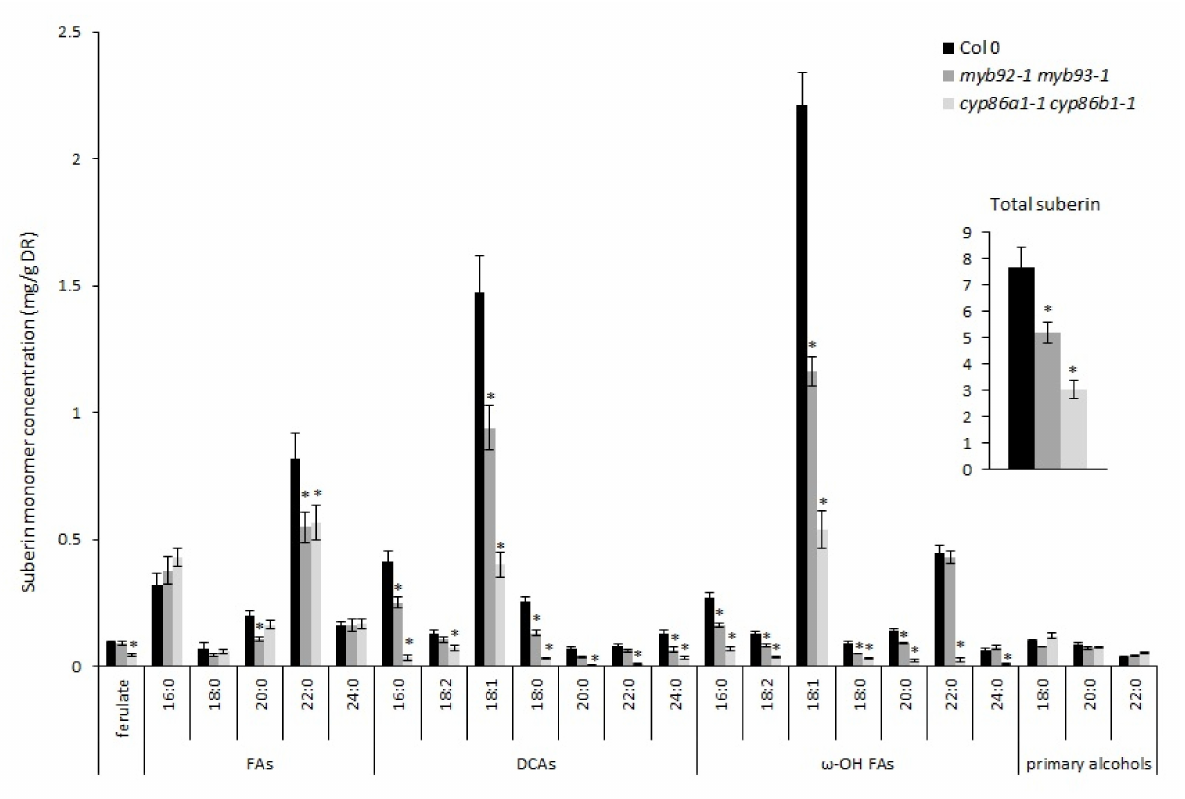
Figure 4. Comparison of root suberin monomer composition between the wild type (Col-0) and mutants myb92-1 myb93-1 and cyp86a1-1 cyp86b1-1 . Mean values are shown in milligrams of suberin monomer per gram of delipidated dry residue (DR) from 3–4 replicate samples ± SE. A replicate consisted of a pool of 4 plants at 4 weeks of age. Inset represents the total poly-aliphatic Scheme 0. FA, fatty acids; DCA, dicarboxylic acids; ω -OH FA, omega-hydroxy fatty acids. Asterisks indicate p < 0.05 by Student’s t -test comparing the values of the mutants to wild-type (Col